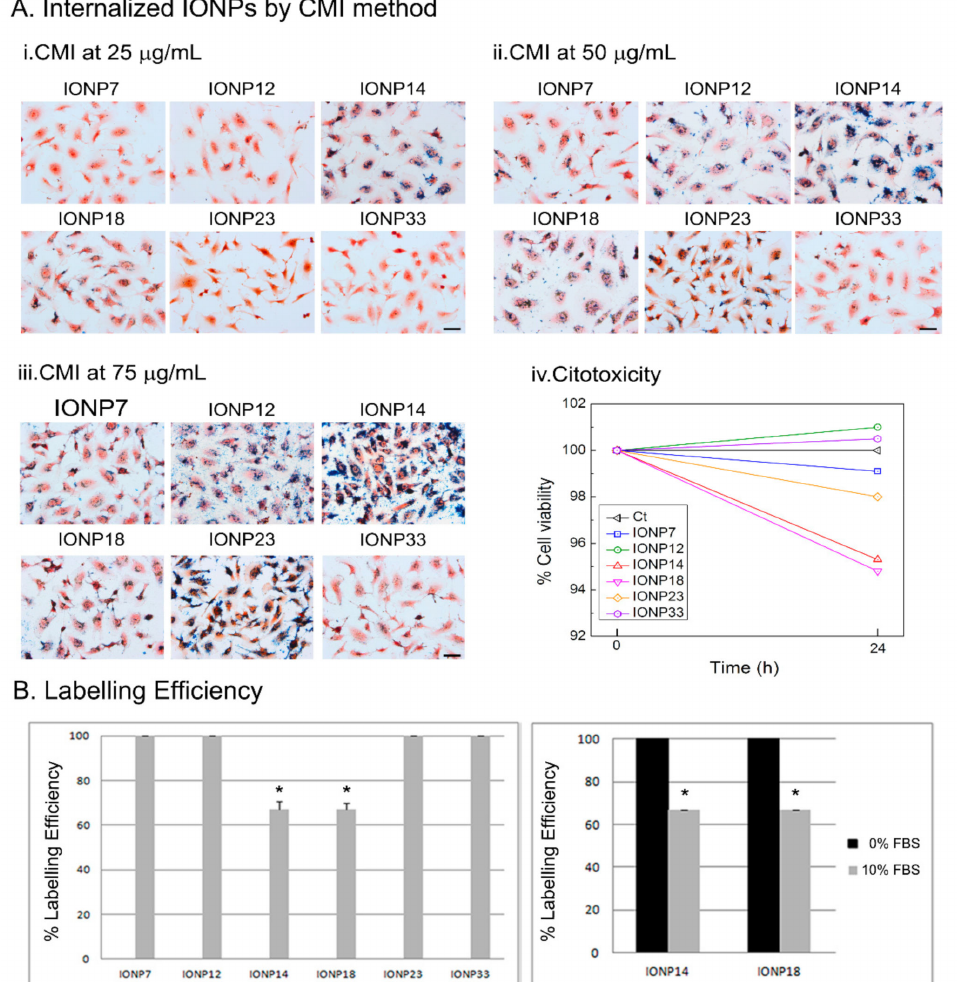
Figure 4. ( A ) Labelled cells by IONPs using CMI method. Optical images after Prussian blue staining of U373 cell line using different IONPs concentrations of (i) 25 µ g/mL, (ii) 50 µ g/mL, and (iii) 75 µ g/mL and (iv) cell viability using 75 µ g/mL of IONPs incubated after 24 h. ( B ) IONPs labelling on U373 cells at an initial concentration of 75 µ g/mL using DMEM supplemented with 10% of FBS (left) or without FBS (right). A significant increase in labelling efficiency was obtained when IONPs were suspended in DMEM+0%FBS compared with DMEM supplemented with 10%FBS for IONP14 and